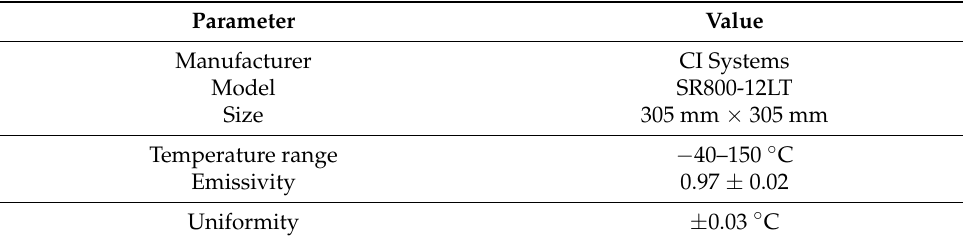
Table 2. Properties of the blackbody